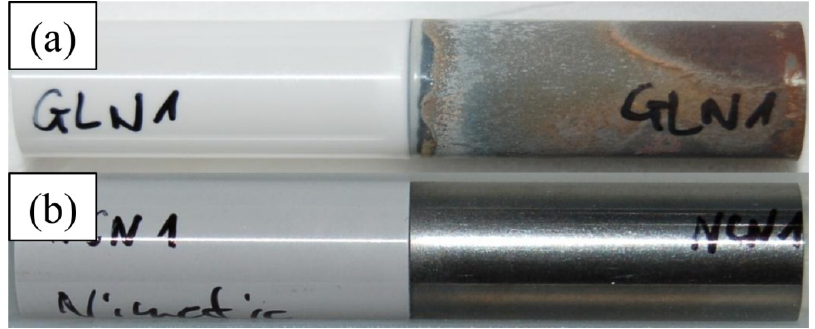
Figure 1. Compound samples after glass soldering ( a ) and adhesive gluing ( b ) of the ceramic and titanium components.